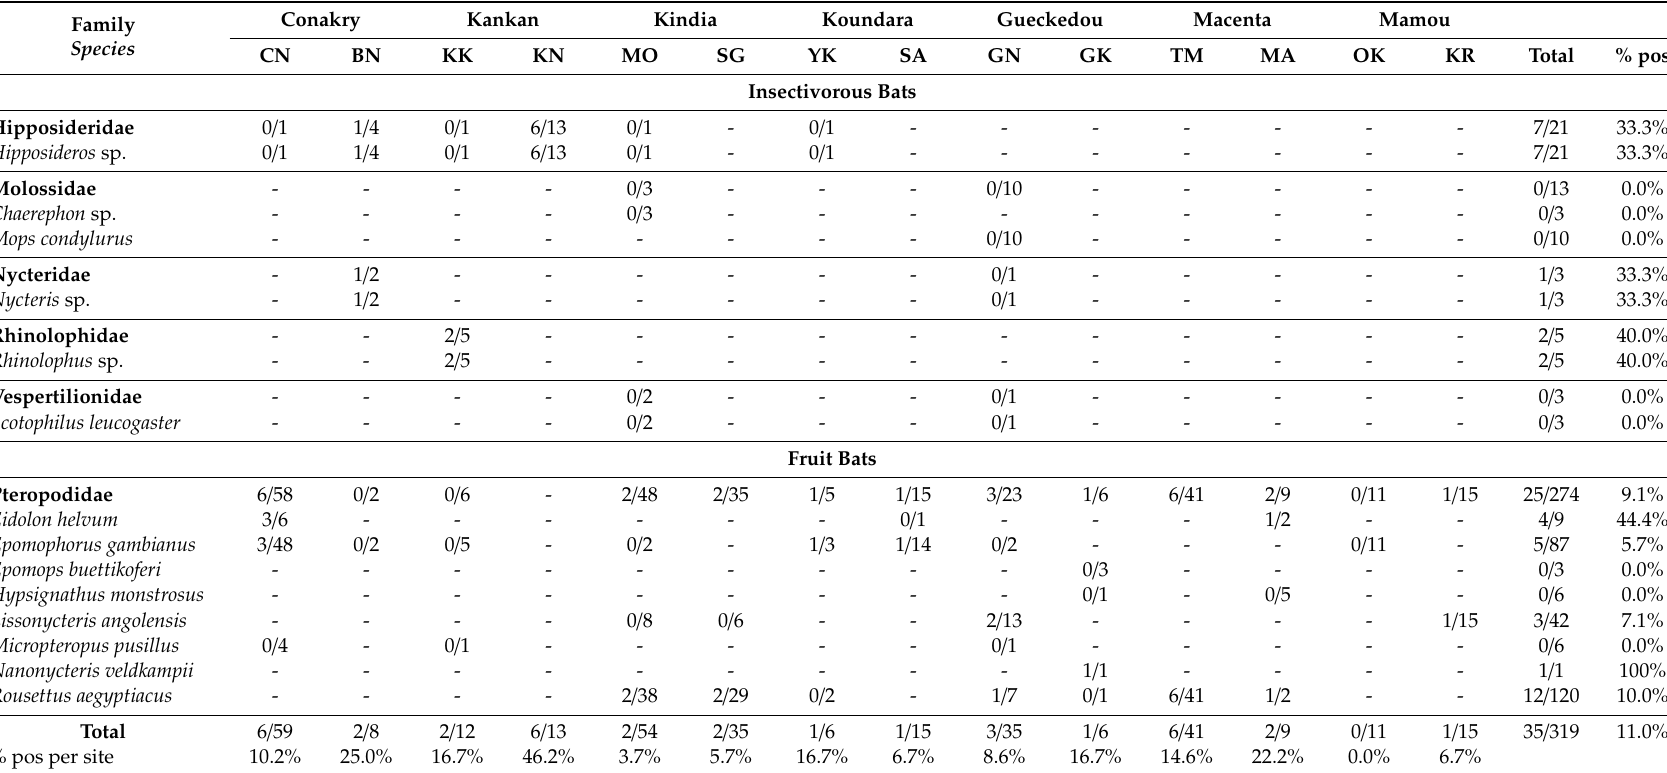
Table 2. Number and percentage of samples positive for coronavirus RNA in di ff erent bat families and species collected in each site. Conakry Kankan Family Species